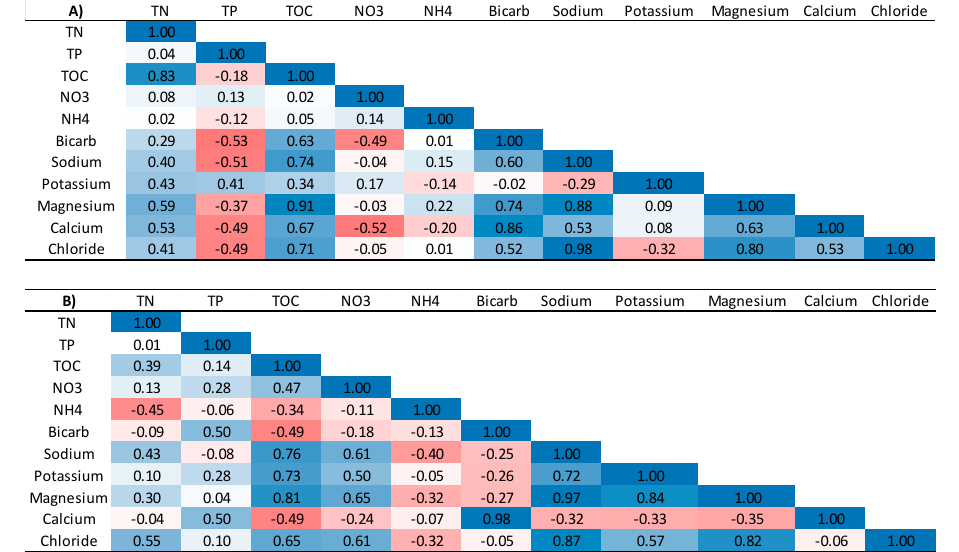
Figure 6. Correlation matrices for: ( A ) groundwater and ( B ) surface water. Blue represents positive correlations and red represents negative correlations. The darker hue of the color is proportional to the strength of the correlation (Adapted from [42]). Table 3. Tukey’s HSD post hoc analysis results comparing constituent concentrations between sites showing only those results with p values ≤ 0.10. SW = surface water and GW = groundwater (Source: [42]).